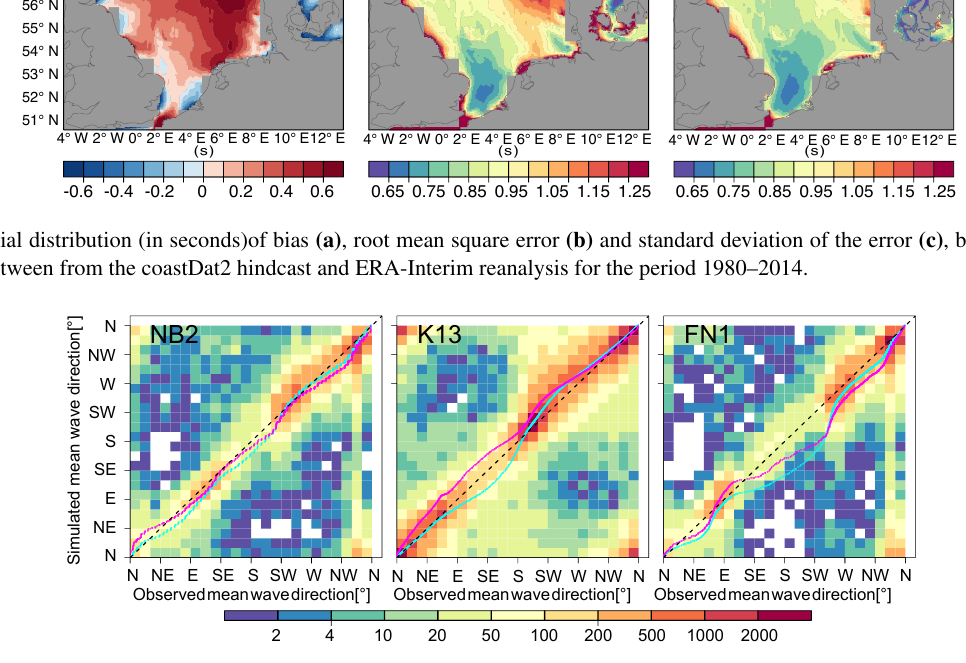
Earth Syst. Sci. Data, 9, 955–968,